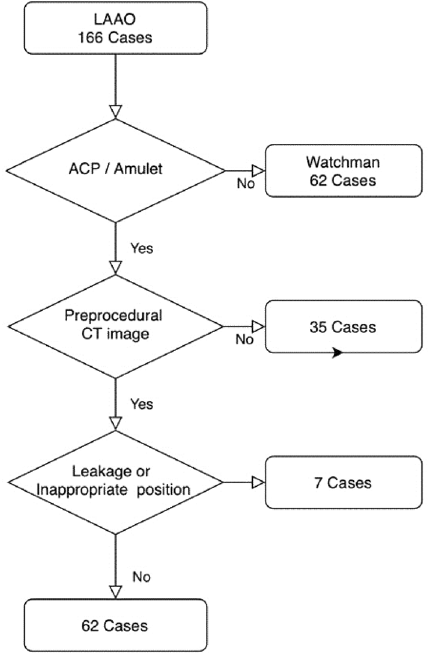
Figure 1. Patient flowchart. LAAO : Left ATRIAL appendage occlusion; ACP : amplatzer cardiac plug; CT : computed